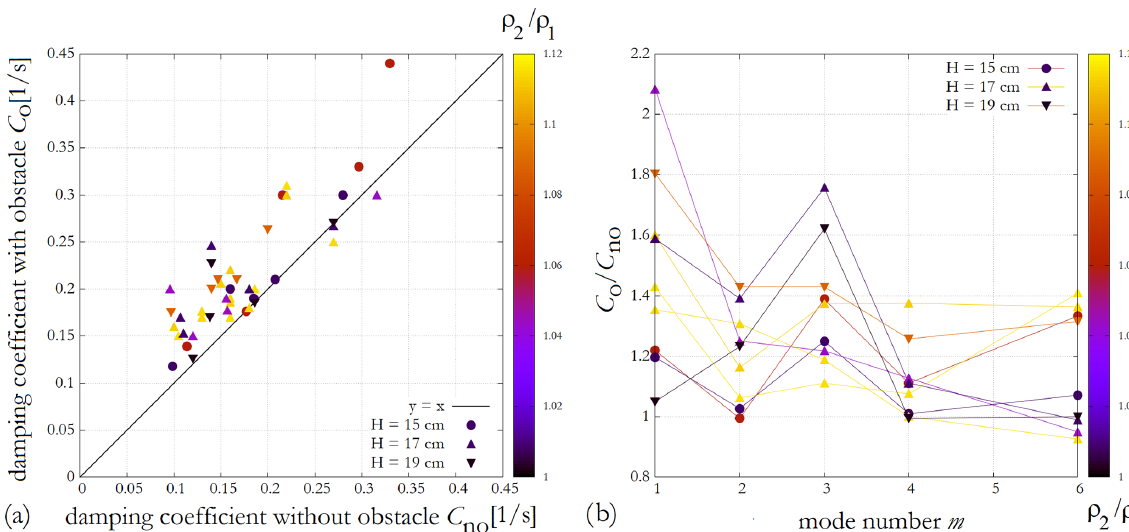
Figure 9. (a) Comparison of dominant mode surface seiche decay coefficients in paired experiments without (horizontal axis) and with (vertical axis) the bottom obstacle. The solid line represents y = x . (b) The ratio of the decay coefficients C o /C no of paired experiments with and without the obstacle as a function of dominant surface seiche mode index m . Symbol shapes and coloring mark the total water depth and the density ratio of the two layers, respectively, in both panels (see legend).